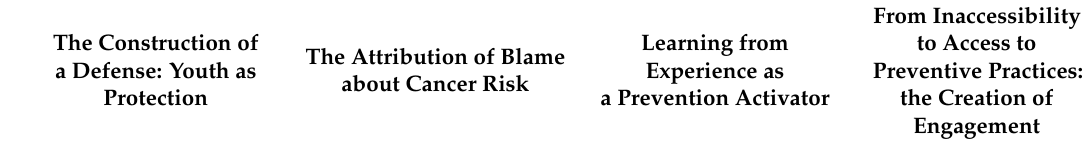
Table 1. Constructs, themes and distribution of metaphors about cancer prevention in invented